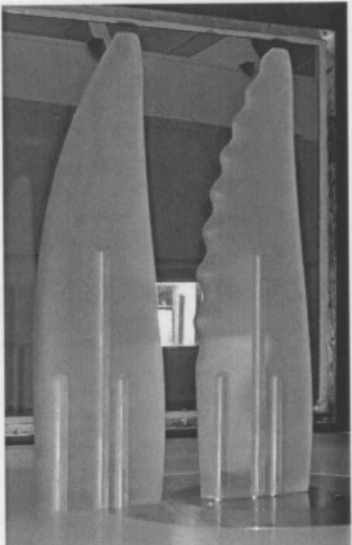
Figure 7. 3D scale model of an idealized humpback whale flipper with and without sinusoidal leading edges, reprinted from [60] with permission from AIP Publishing.